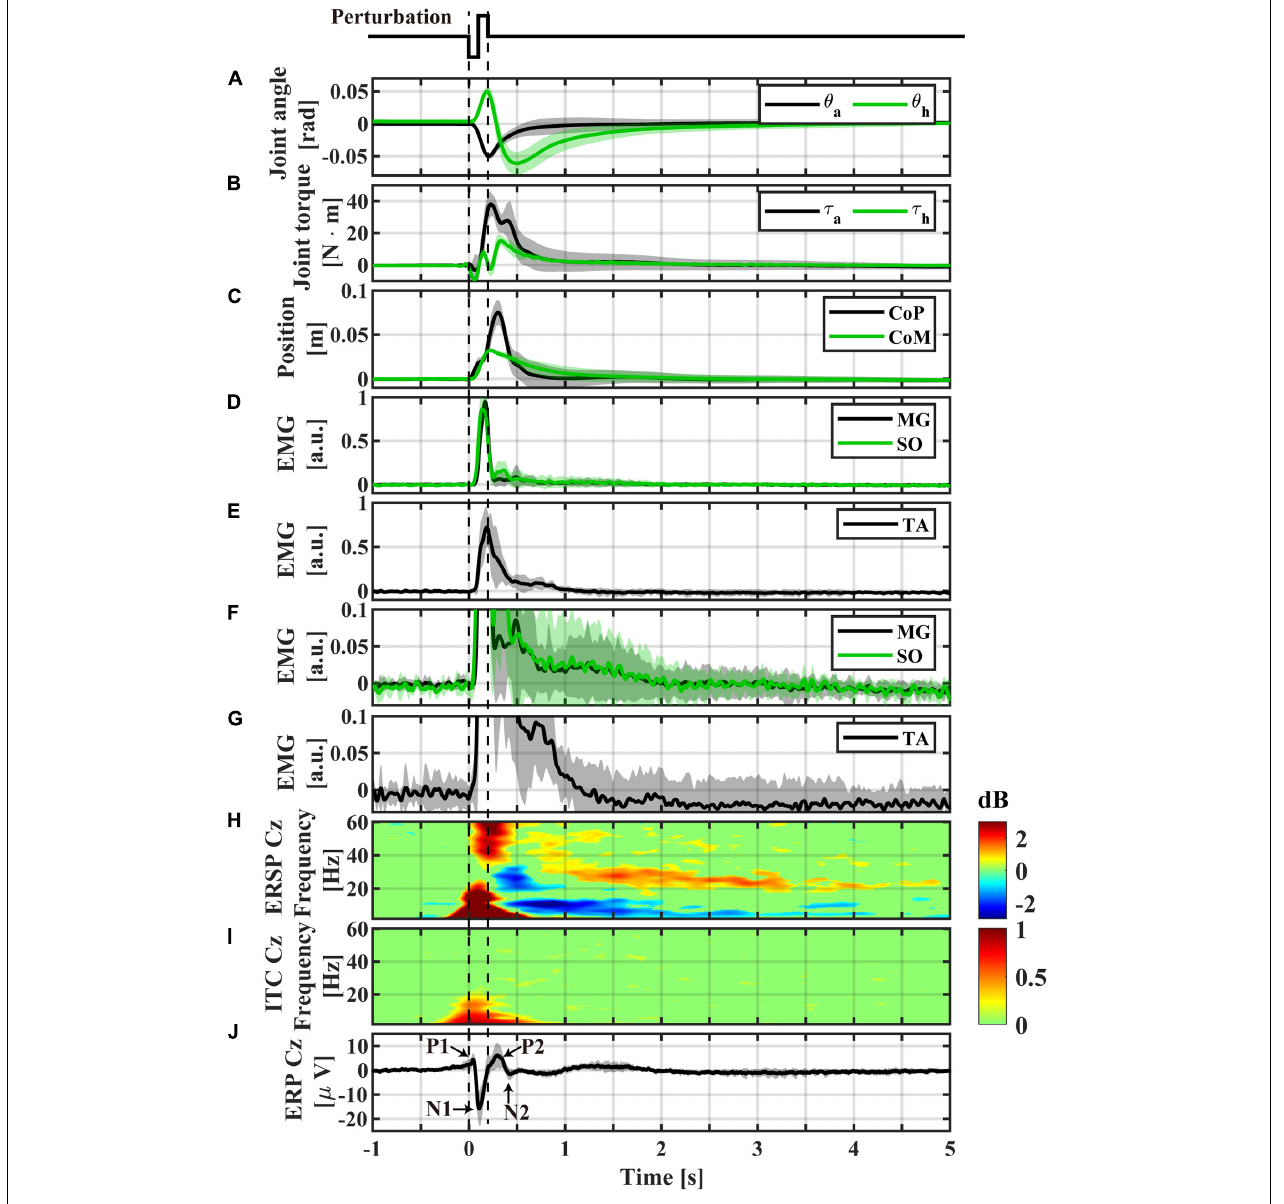
FIGURE 3 | Event-locked average profiles (averaged across participants) triggered by the perturbation-onset. (A) Ankle and hip joint angles, (B) joint torques obtained by the inverse dynamics analysis, (C) CoP and CoM positions, (D) normalized EMGs of Medial-Gastrocnemius and Soleus, (E) normalized EMG of Tibialis Anterior, (F) magnification of panel (D) , (G) magnification of panel (E) , (H) ERSP of Cz electrode, (I) ITC of Cz electrode, (J) ERP of Cz electrode. The light color shaded area in each of panel (A–G,J) is the standard deviation, representing the distribution across participants. Non-significant differences from baseline (bootstrap statistics, p > 0.05) were set to 0 dB and colored by green in panels (H,I) . Powers for areas with red and blue (non-green) colors were significantly larger (i.e., ERS) and smaller (i.e., ERD) than the baseline power,